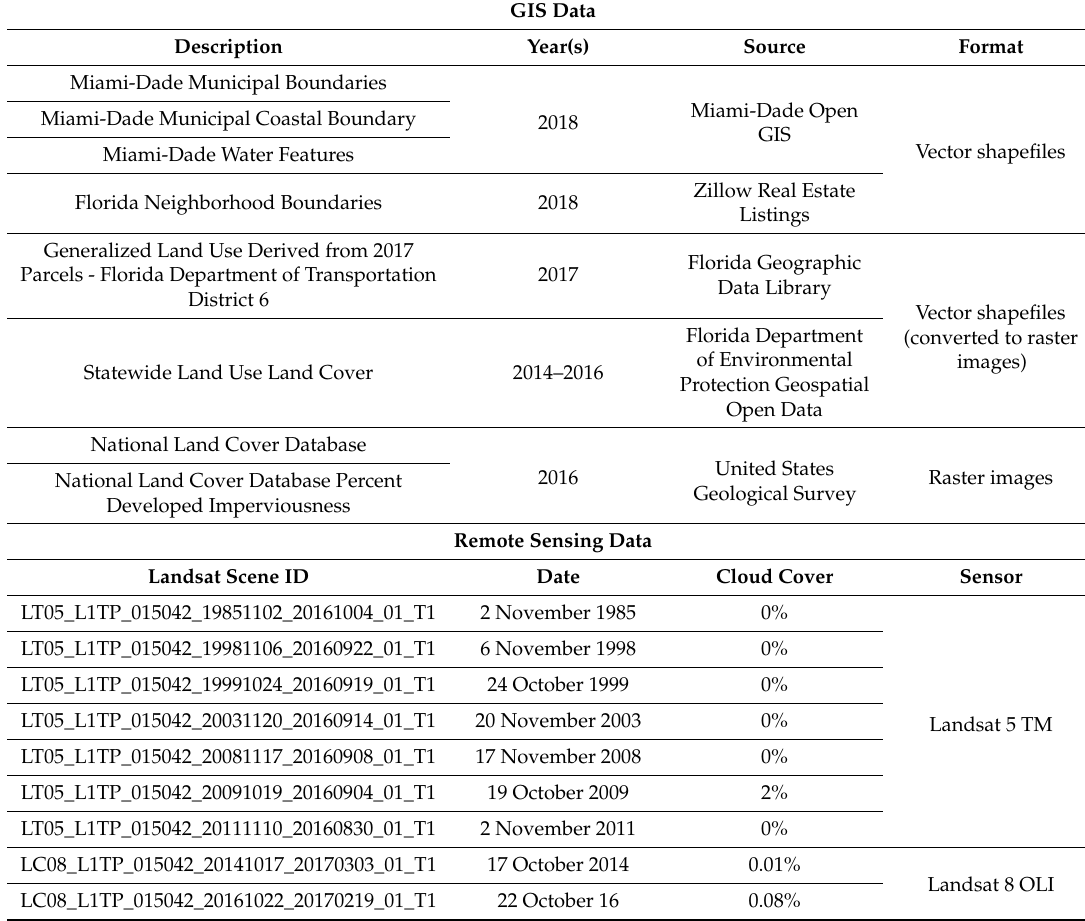
Table 1. Inventory of all of the geospatial data used during this study, including descriptive